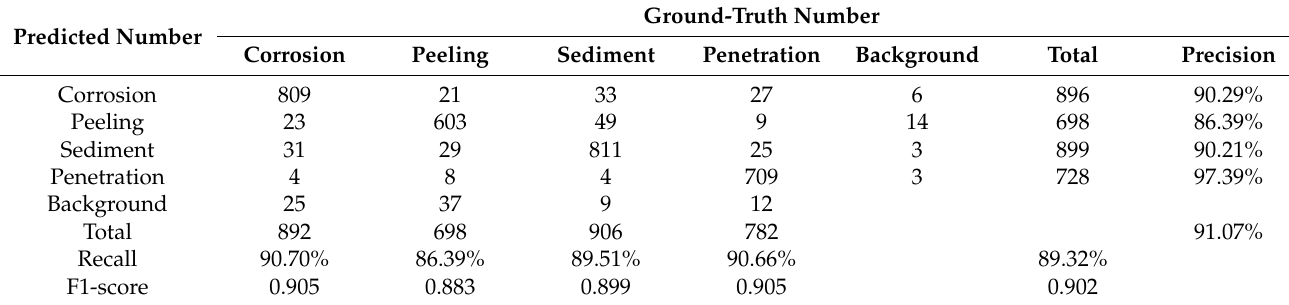
Table 10. Defect detection results of YOLO v5 with